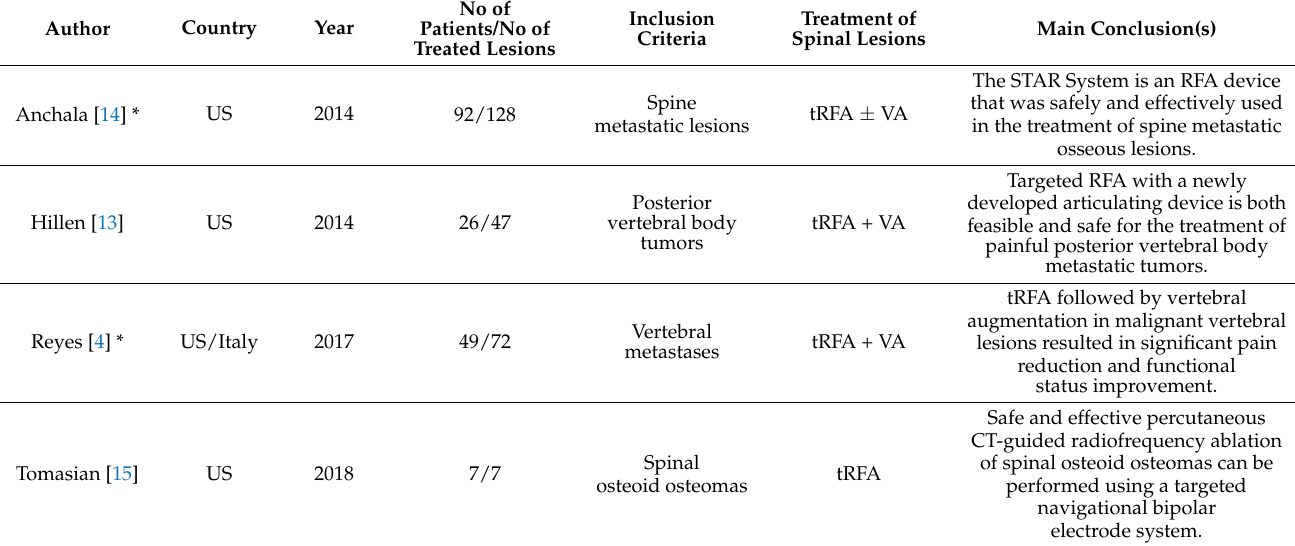
Table 1. Summary of studies reporting on the use of a navigational radiofrequency ablation device for the treatment of spinal